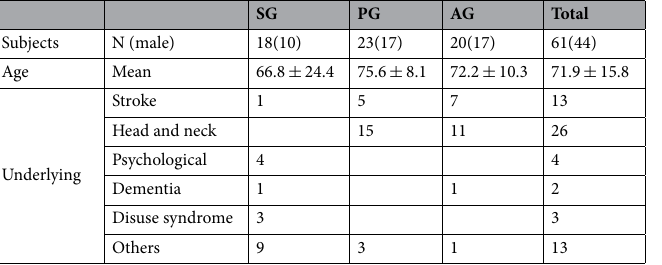
Table 1. AD values of PG and AG were